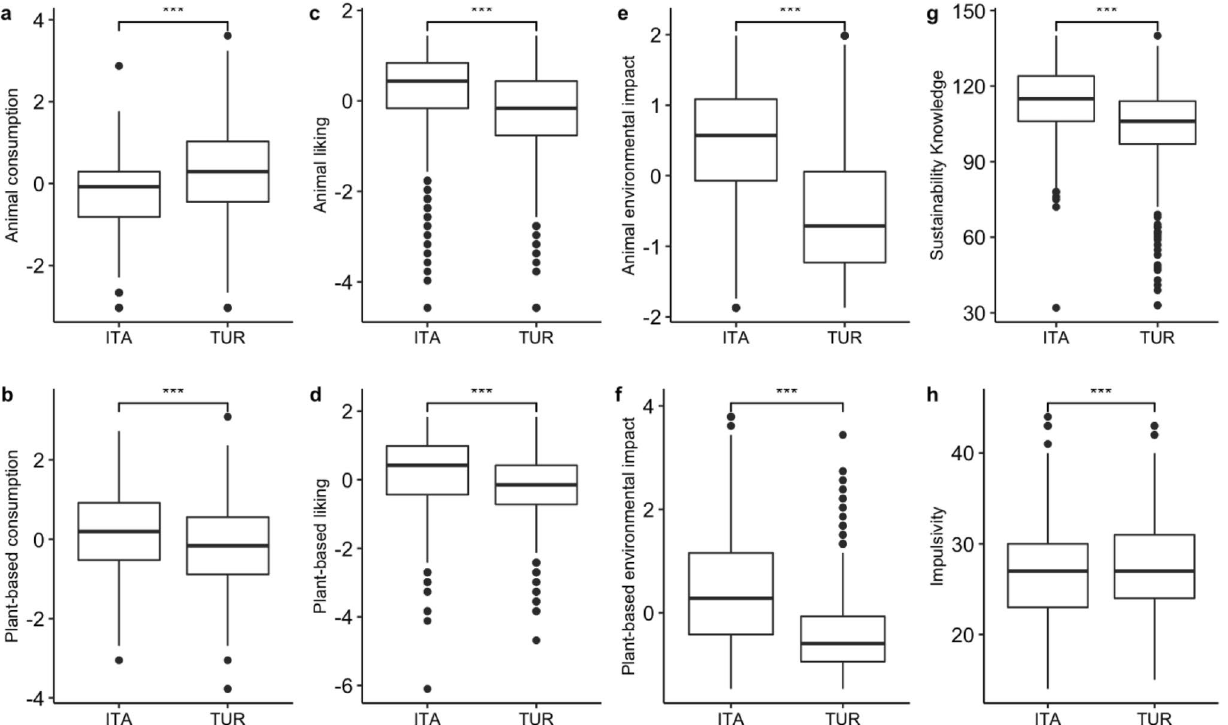
Figure 1. Main differences between the Italian (ITA) and the Turkish (TUR) samples. ( a ) Animal consumption, ( b ) animal liking, ( c ) animal environmental impact, ( d ) sustainability knowledge, ( e ) plant-based